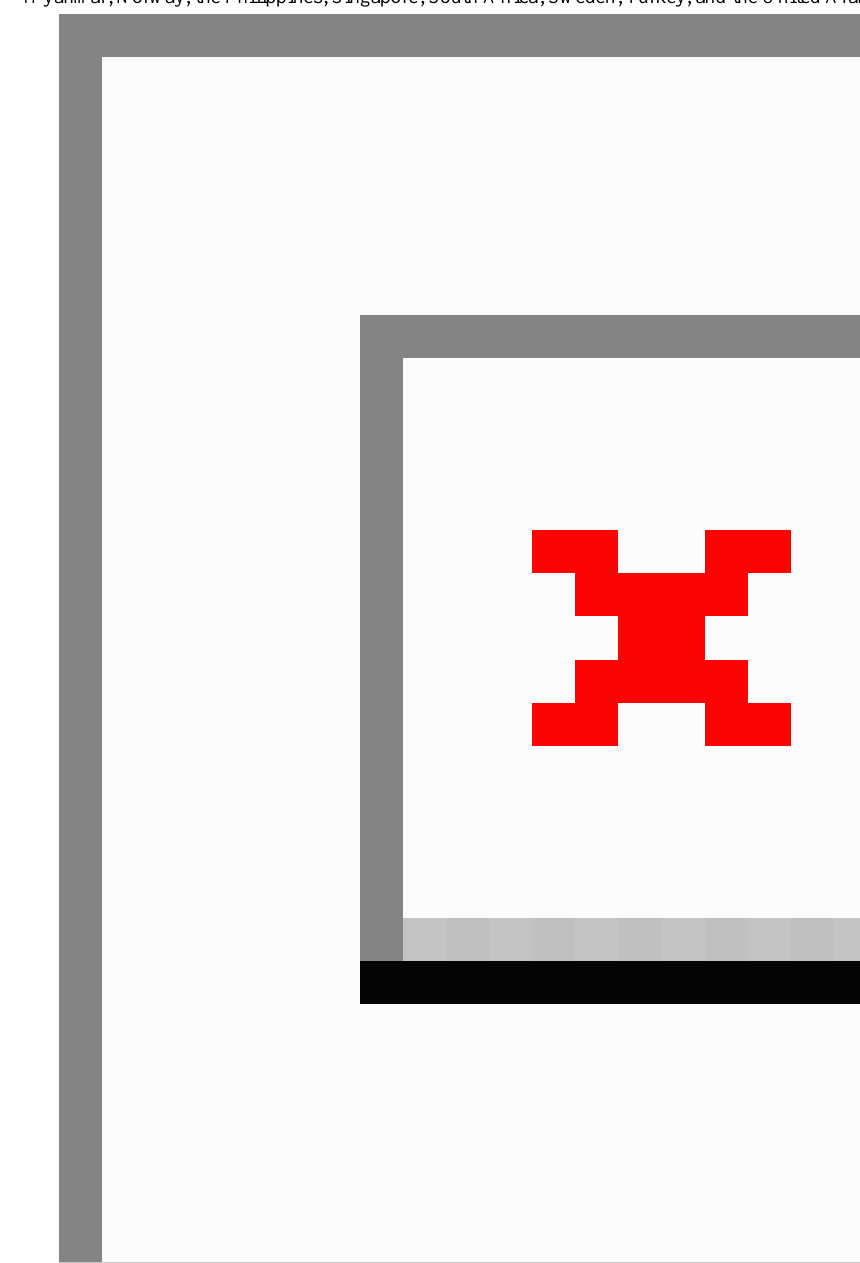
Figure 1. Cases epidemiologically linked to overseas or interstate travel (n=178). *Others: Argentina, Cuba, Egypt, Hong Kong, Indonesia,